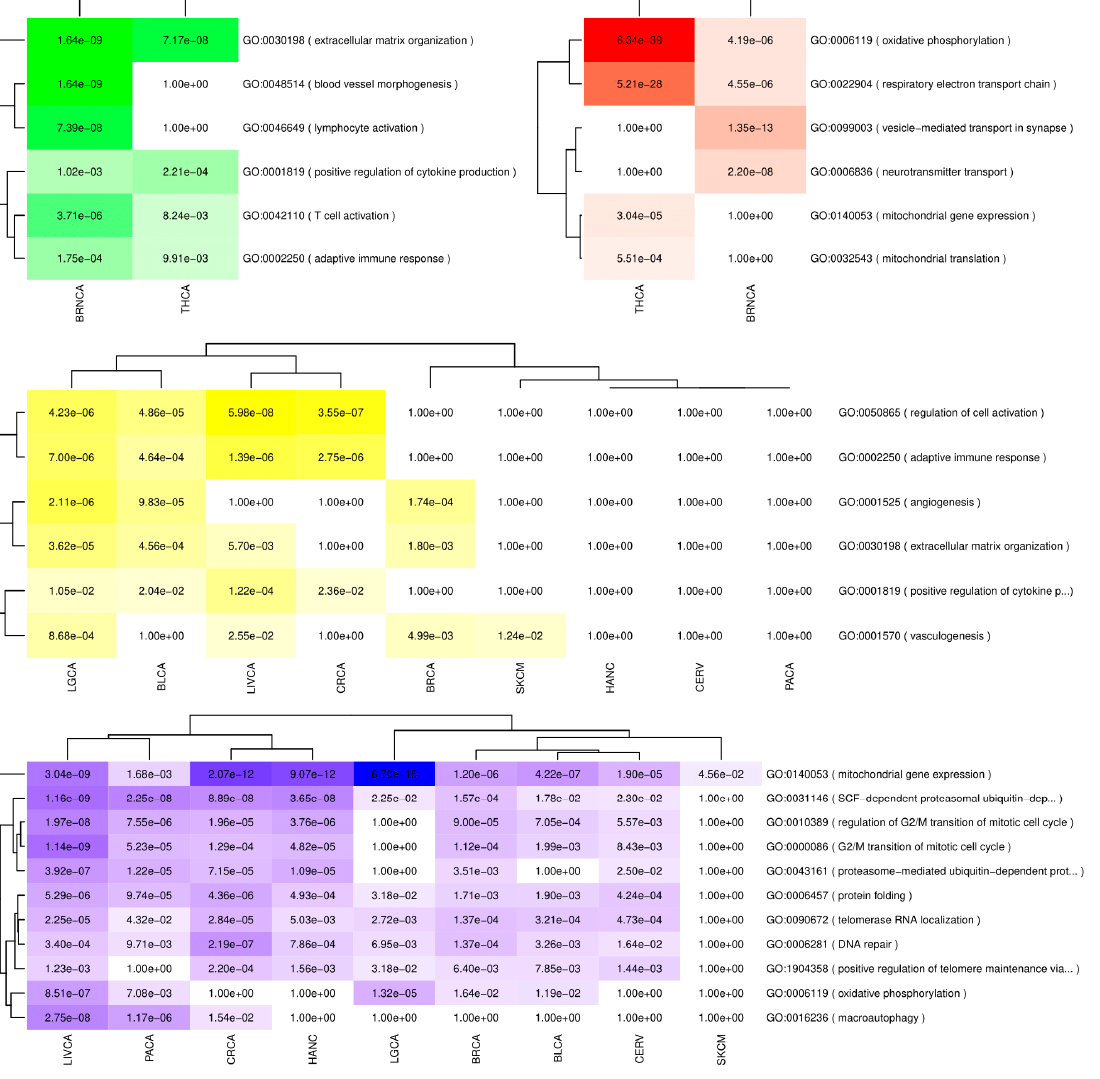
Figure 2. GO overrepresentation analysis results of genes significantly deregulated in AD and cancers. ( A ) Genes upregulated in AD and its SDDCs. ( B ) Genes downregulated in AD and its SDDCs. ( C ) Genes jointly upregulated in AD and downregulated in its ODDCs. ( D ) Genes jointly downregulated in AD and upregulated in its ODDCs. Color hues are proportional to the FDR adjusted p-vales of the overrepresentation results, with darker hues corresponding to lower p -values.